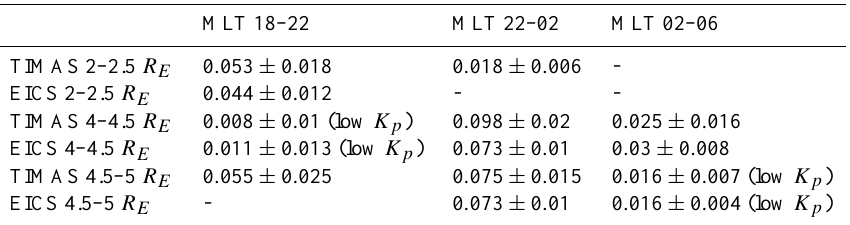
Fig. 2. Same as Fig. 1, but for conditions when the satellite footpoint is in darkness. Table 2. TIMAS and EICS ion beam occurrence frequency when footpoint is in darkness; for high K p conditions, except when noted